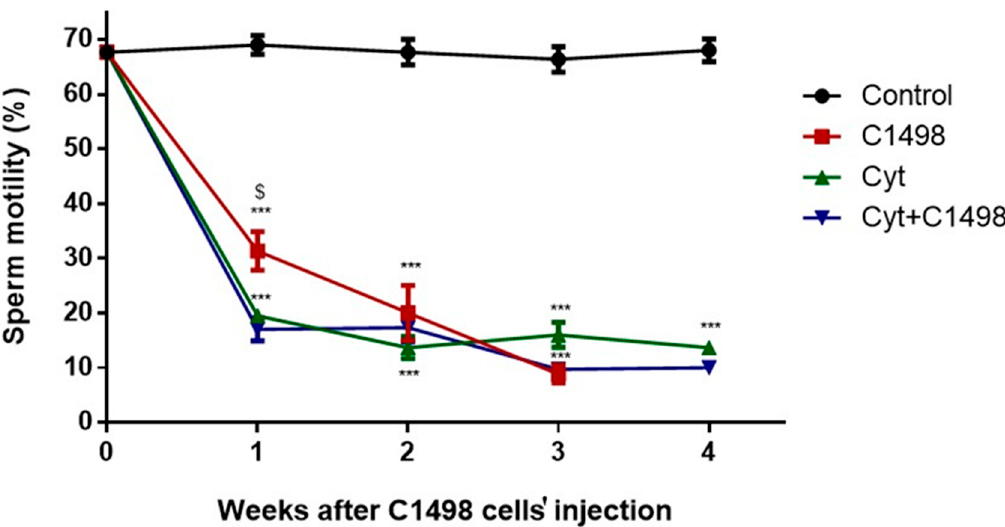
Figure 3. Effect of AML cells, cytarabine, and the combination of both on sperm motility: Mice were treated as described in Figure 1. Sperm were extracted from the epididymis 1–4 weeks post-treatment. Sperm motility/immotility was evaluated using a Makler counting chamber and determined as a percentage of total sperm according to WHO criteria. The results are representative of three independent experiments with 8–10 mice in each group. * Significant compared to control. $ Significant for Cyt + C1498 compared to C1498. *, $ p < 0.05; **, $$ p <0.01; ***, $$$ p < 0.001.